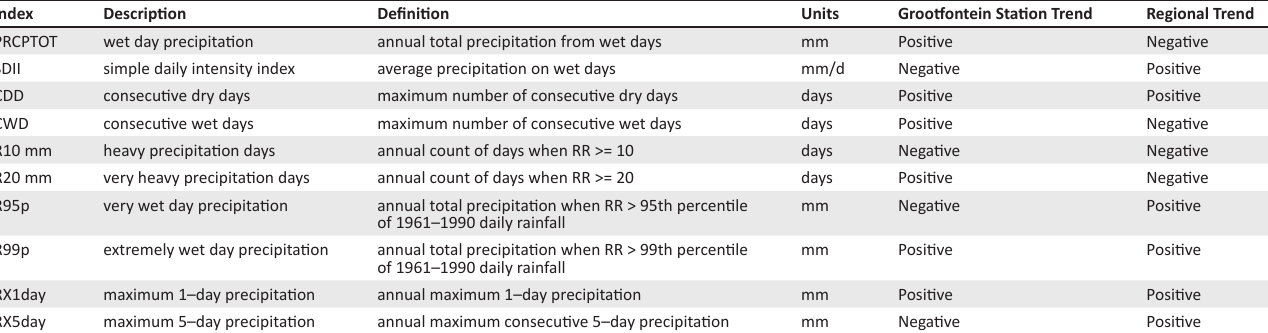
TABLE 2: The ten climate change extreme daily indices used for this